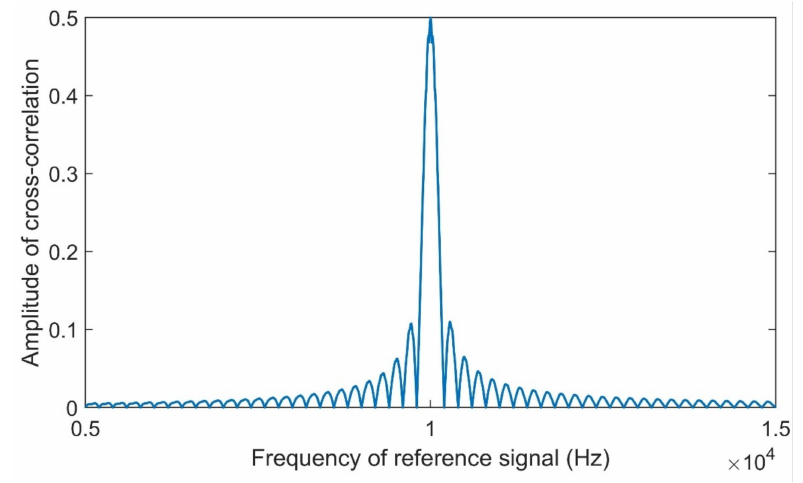
Figure 2. Exemplary cross-correlation spectrum.